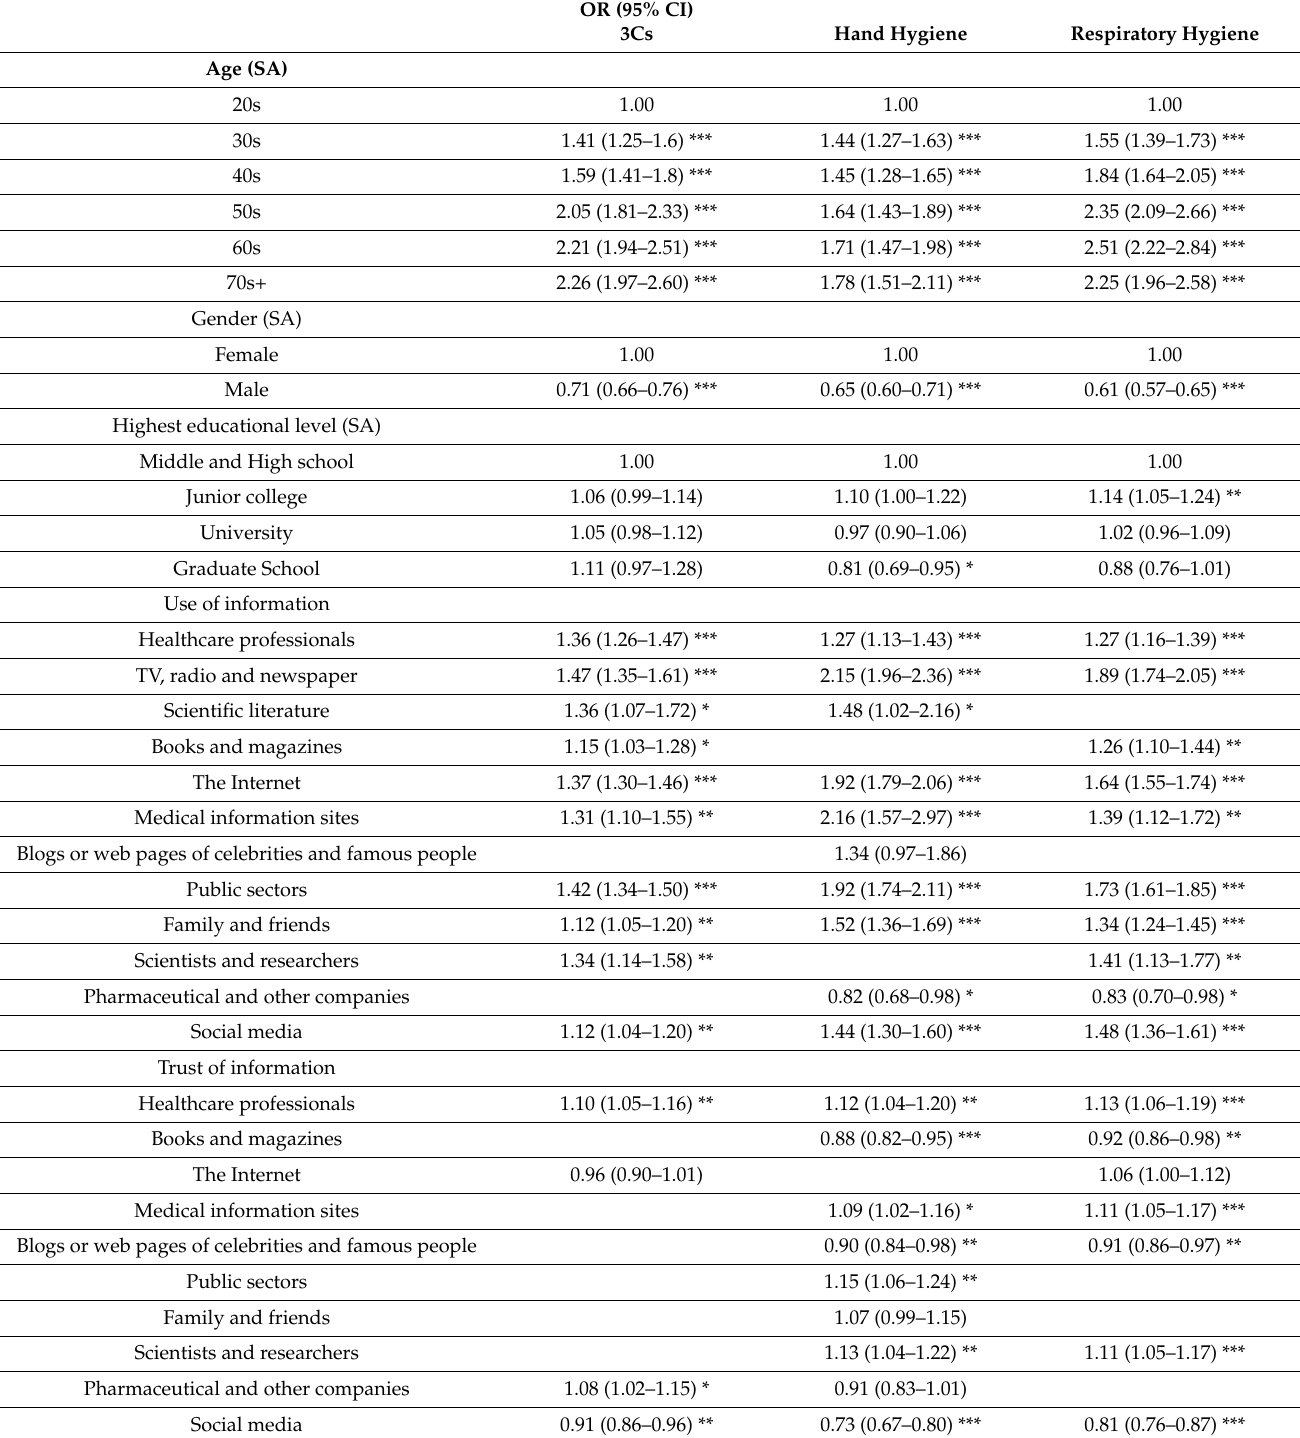
Table 2. Factors associated with the COVID-19 preventive